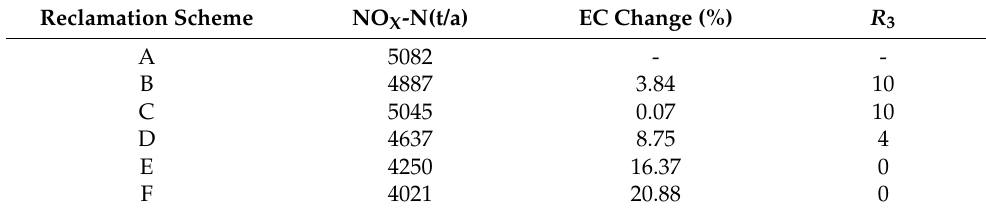
Table 21. Feasibility evaluation of NO X -N environmental